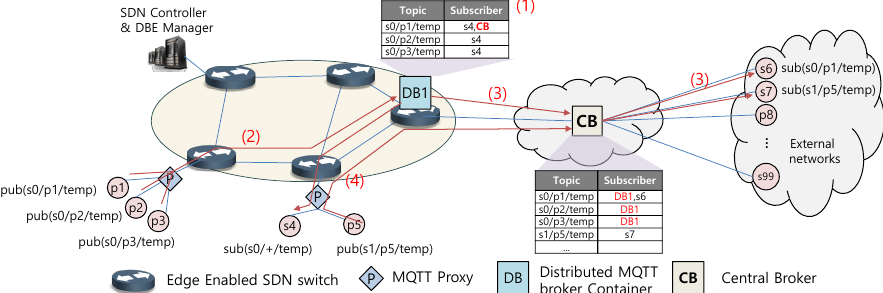
Figure 4. Operation of the distributed broker architecture of the proposed